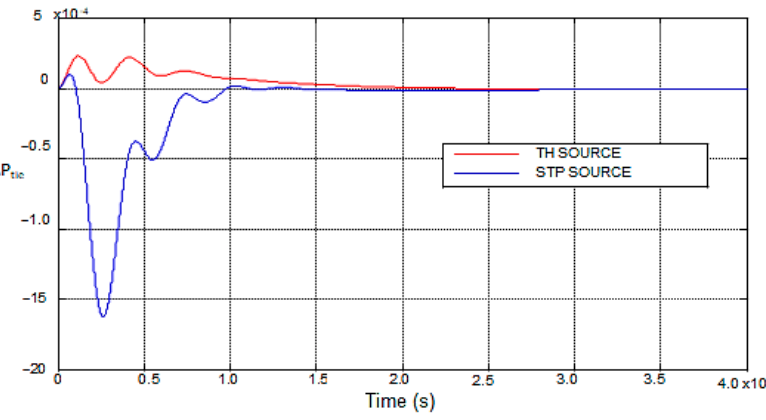
Figure 8. Changes in frequency in area 2 without and with STP (SLP two percent).